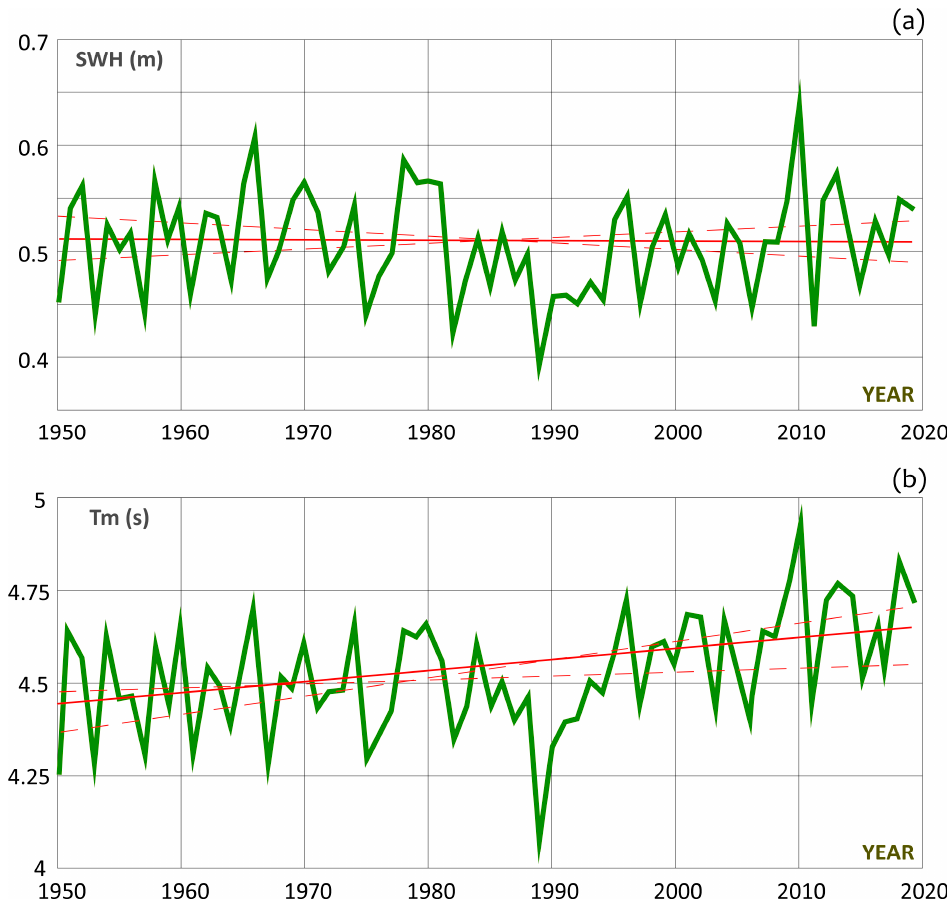
Figure 9. ERA5 reanalysis dataset 1950–2019. Green lines illustrate the mean annual SWH ( a ) and Tm ( b ). The MK and SSE tests at 95% confidence intervals are represented with solid and dashed red lines respectively. Table 5. SWH monthly, seasonal, and annual analyses. The MK trend is reported in the second and third columns. Non-significant values are identified with “//”. A 90% significance level is highlighted with “S”, 95% with “SS”, and 98% with “SSS”. The right-side column reports the Sen’s slope estimator A. Period Test Z